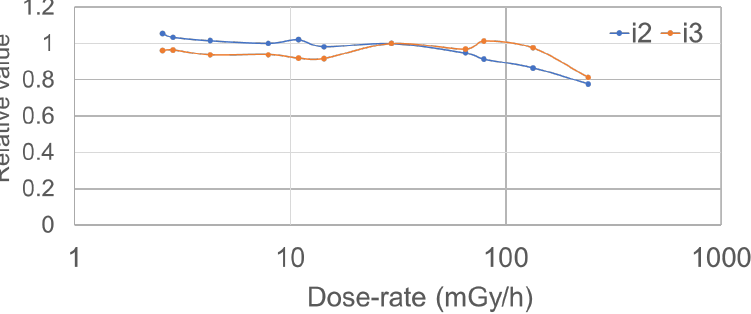
Figure 7. Dose-rate dependencies (vertical axis: i3 or i2 measurements/ionization-chamber measure- ments; horizontal axis: ionization-chamber measurements).